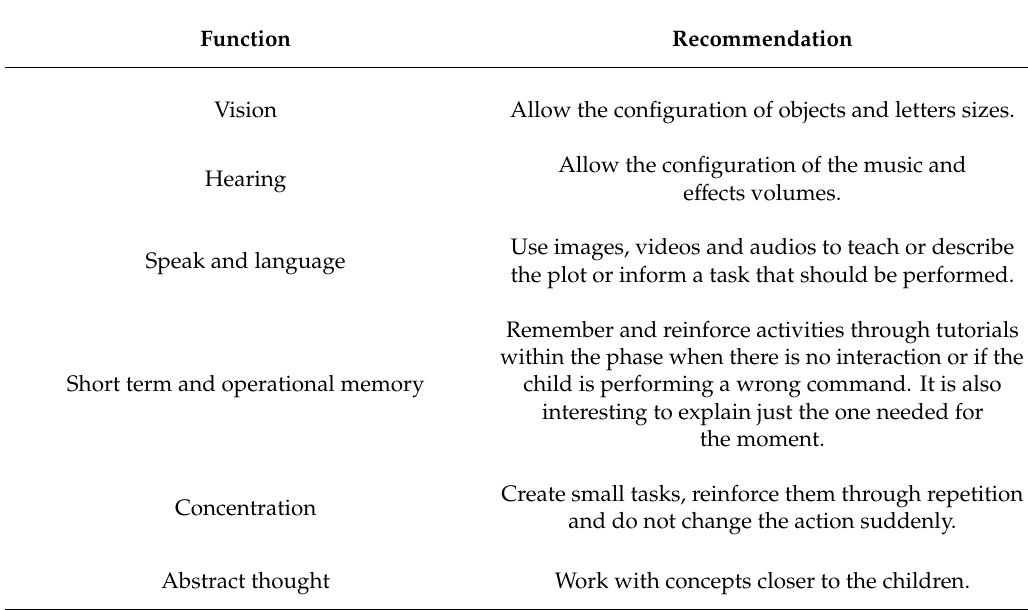
Table 1. Recommendations for the development of accessible games for people with Down syndrome based on the possible impairments